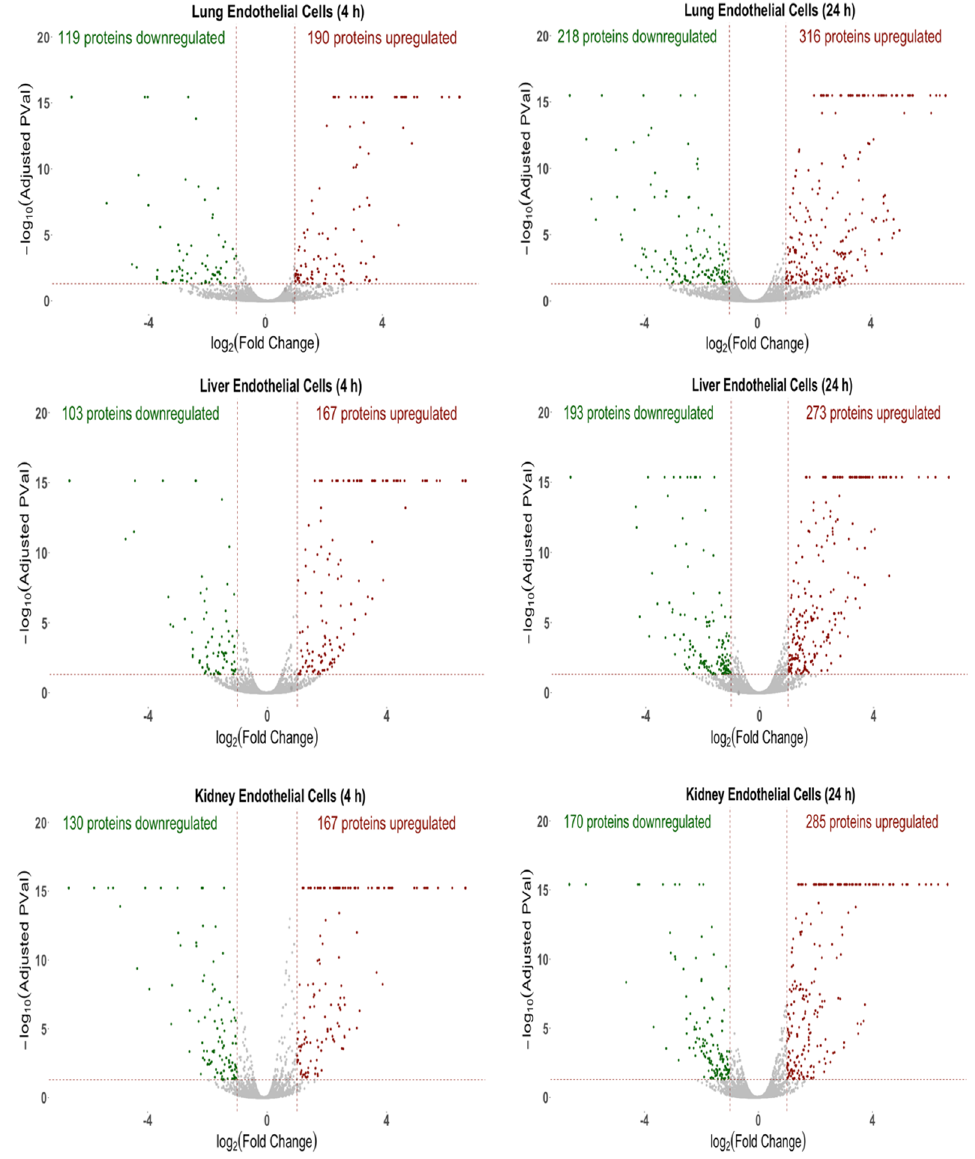
Figure 1. Volcano plots of the protein changes for the 4 h and 24 h cytomix-treated ECs as compared to control. For all three organs, the red represents upregulated proteins, green represents downregulated proteins and gray represents proteins that were not significantly altered in response to cytomix treatment.